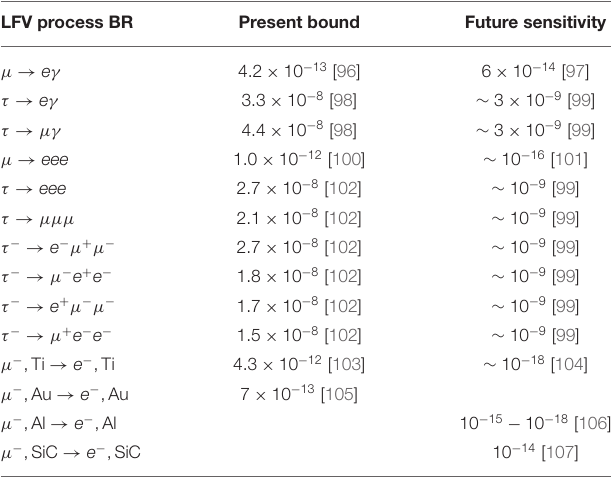
TABLE 1 | Experimental 95 % C.L. upper bounds on HLFV branching ratios from the ATLAS and CMS collaborations.